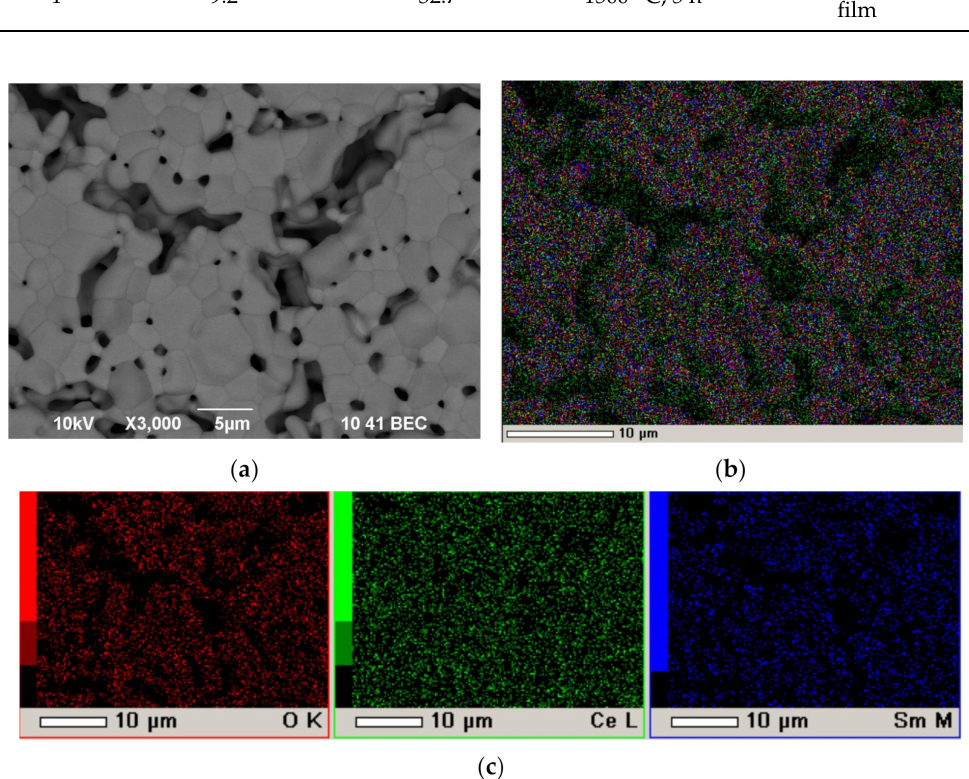
Figure 11. The surface of the SDC electrolyte layer after intermediate sintering at a temperature of 1450 ◦ C for 5 h on the porous NiO-SDC anode substrate with a platinum sublayer: ( a ) SEM image; ( b ) integral map of the elements’ distribution; ( c ) individual element